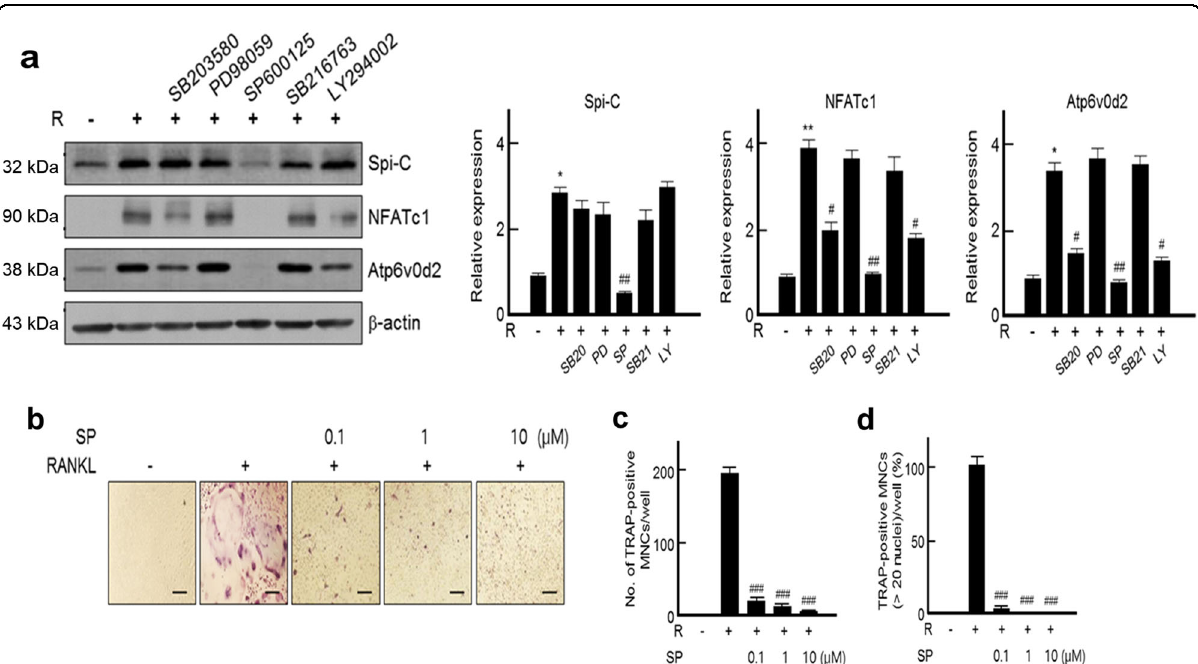
Fig. 6 Regulation of Spi-C expression through the JNK signaling pathway. a Isolated BMMs were pretreated with the indicated inhibitors as described in Fig. 5a and incubated with RANKL (200 ng/ml) for 3 days. Then, the cells were lysed and subjected to western blot analysis. Actin was used as a loading control (left panel). The protein bands were quanti fi ed by densitometry, and the levels of Spi-C, NFATc1, and Atp6v0d2 were normalized to the levels of actin. The relative expression levels in the stimulated cells compared with the untreated cells are shown (right panels). The results are representative of at least three independent experiments. b – d Isolated BMMs were pretreated with the indicated concentrations of SP600125 (SP) for 30 min and incubated with RANKL (200 ng/ml) for 5 days. Then, TRAP staining was performed (original magni fi cation, ×100) b , and the number of TRAP + MNCs (>3 nuclei) or large TRAP + multinucleated osteoclasts with >20 nuclei d were counted and are presented as relative percentages (%). Scale bars, 100 μ m b . The data are presented as the mean ± SD of three independent experiments. * p < 0.05, ** p < 0.005 vs. untreated cells and # p < 0.05, ## p < 0.005, ### p < 0.001 vs. RANKL - treated